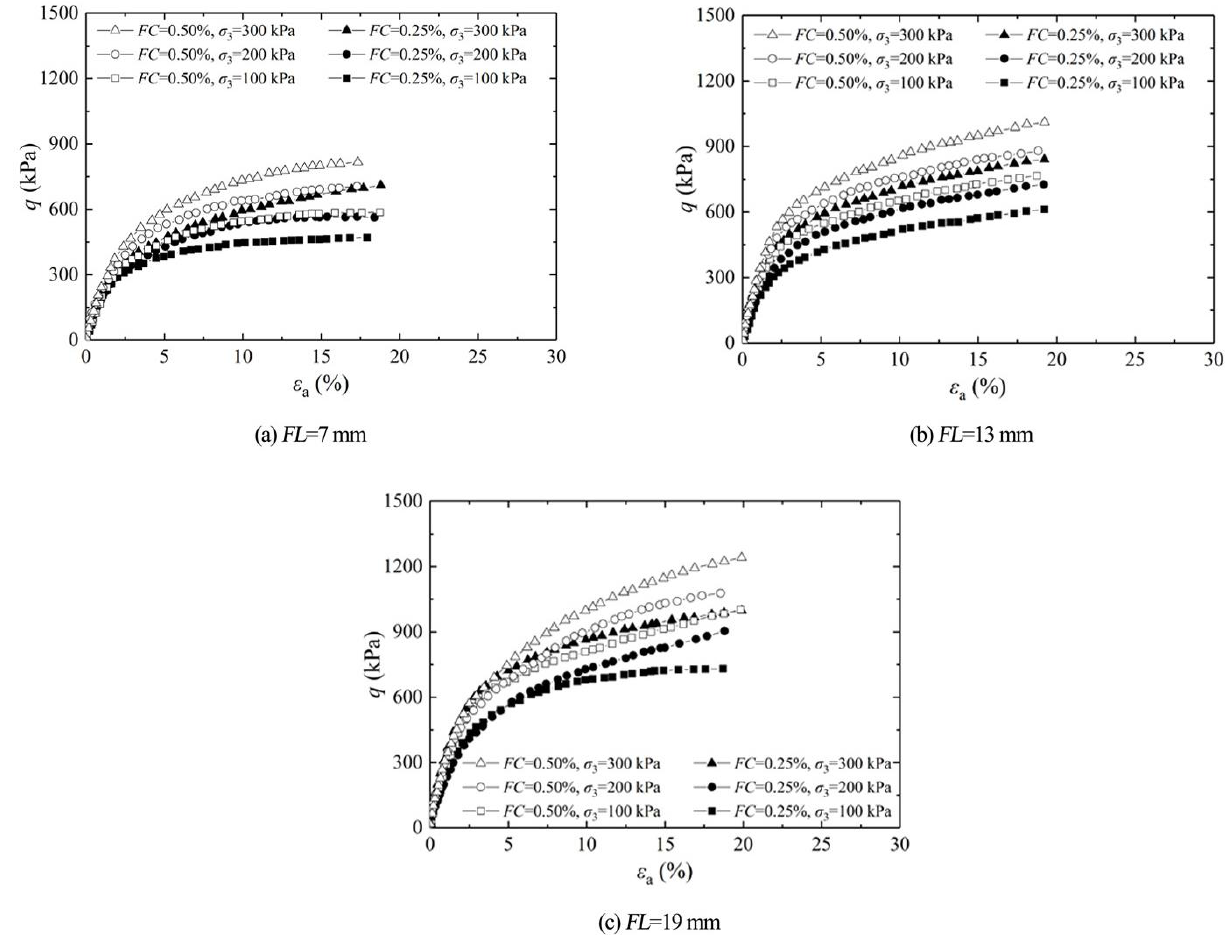
Figure 4. Effect of cell pressure on stress-strain.